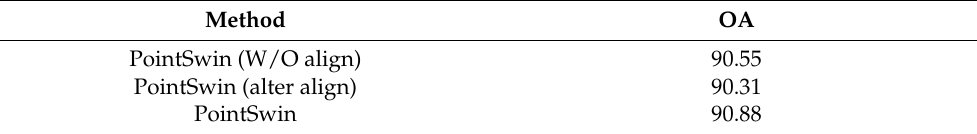
Table 7. Results of ablation experiment about Joint Align Network.